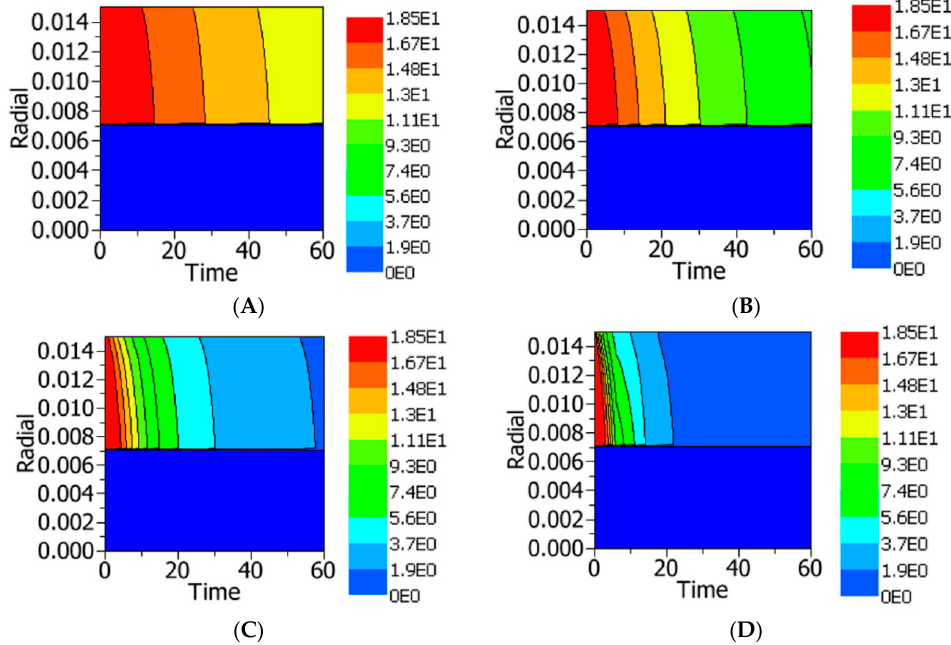
Figure 10. Contour plot of the simulated profile of in vivo residual activity of lipase (U/kg-mes·min) in OPF after heat treatment at ( A —318 K, B —323 K, C —333 K and D —347 K).